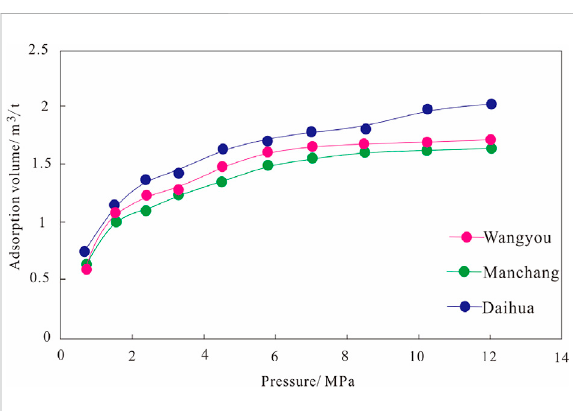
FIGURE 11 Isothermal adsorption curves for the outcrop